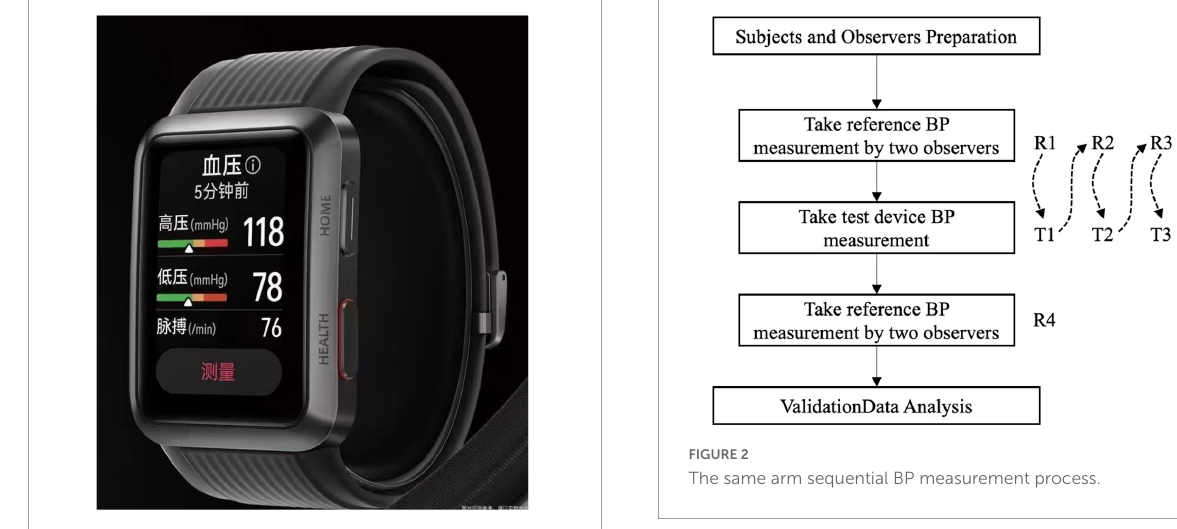
FIGURE1 Illustration of the HUAWEI WATCH. inflation using an algorithm for determining the SBP and DBP; the algorithm is proprietary and cannot be disclosed at this time.